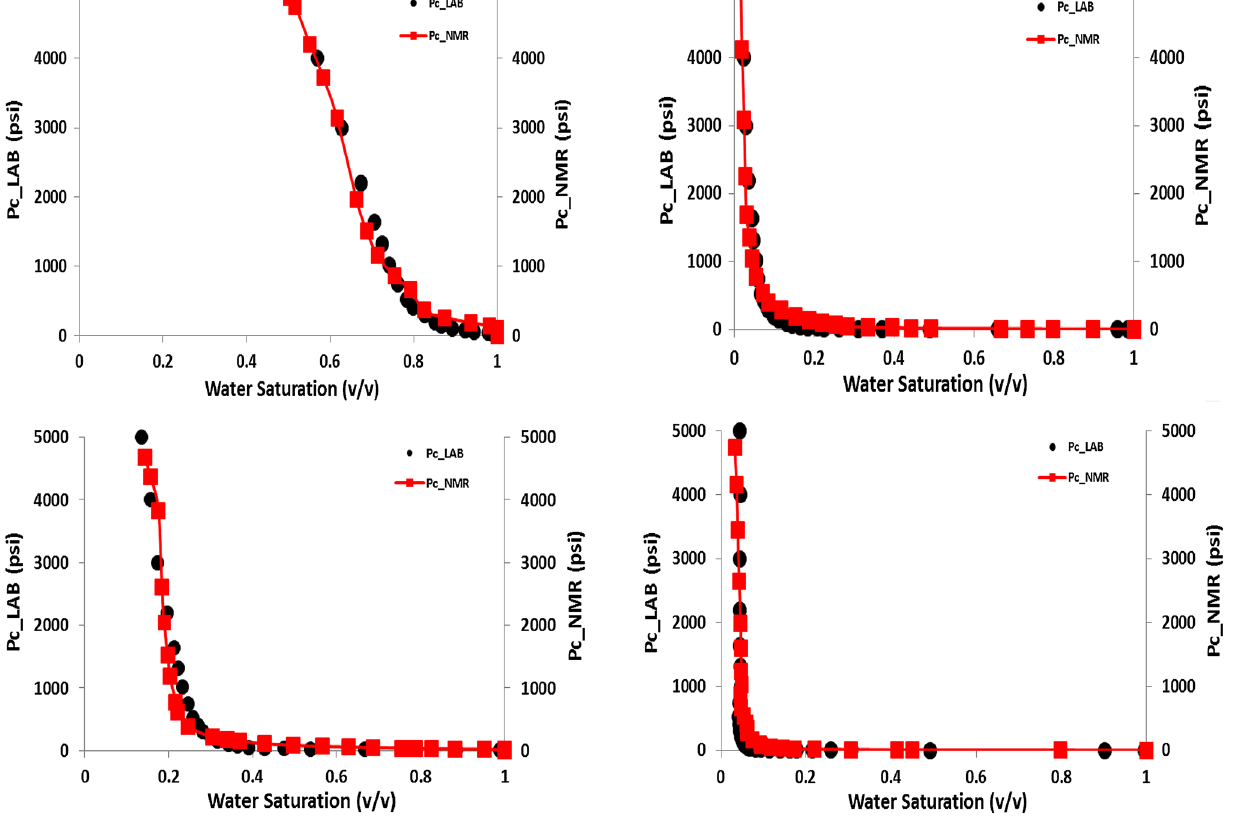
Fig. 24 Calibrated Pc-NMR and Pc-LAB for the channel storey mar- gin (top) and the channel storey axis (bottom) units indicating a good match in capillary attributes (entry pressures and irreducible water